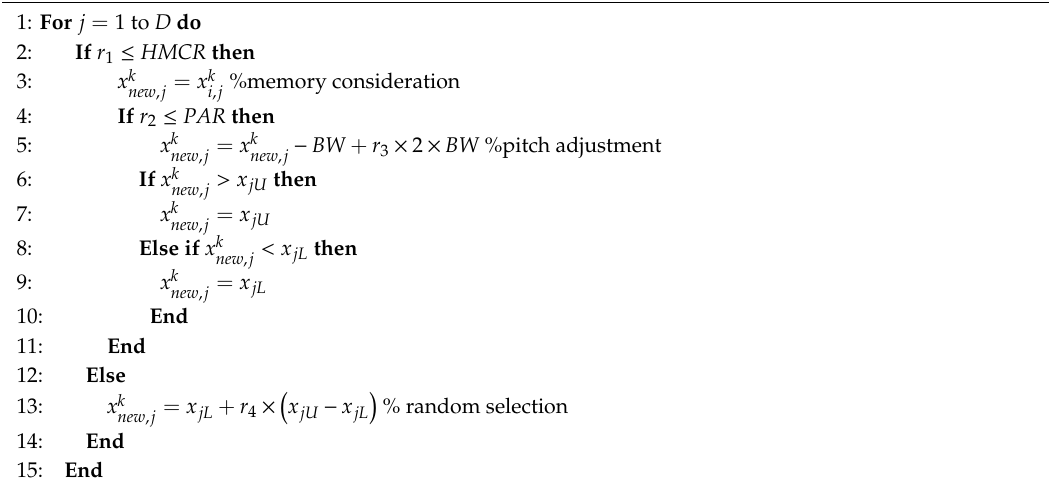
Algorithm 1 The Improvisation of New Harmony in